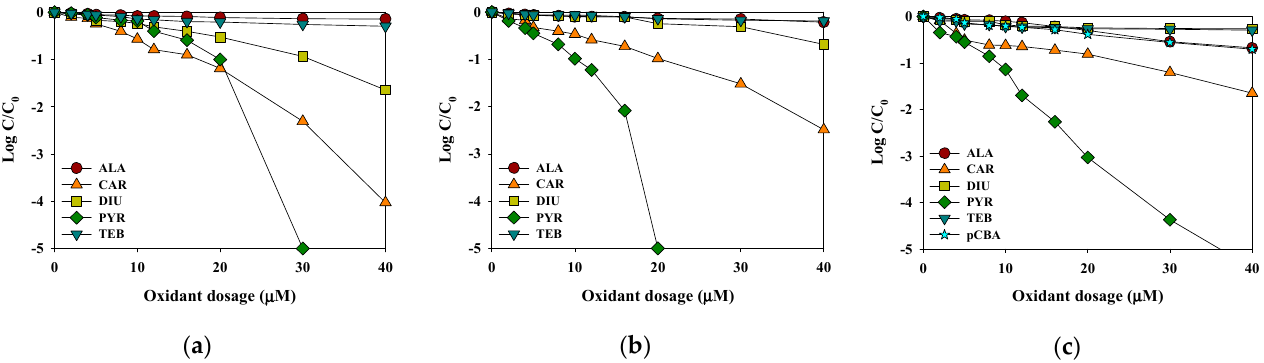
Figure 3. The effects of the oxidant dosage on the removal efficiencies of the selected pesticides by ( a ) HOCl, ( b ) O 3 and ( c ) O 3 /H 2 O 2 (initial concentration of each pesticide and p CBA = 2 μ M, reaction time = 0.5 h, temperature = 25 °C, pH = 6.6).